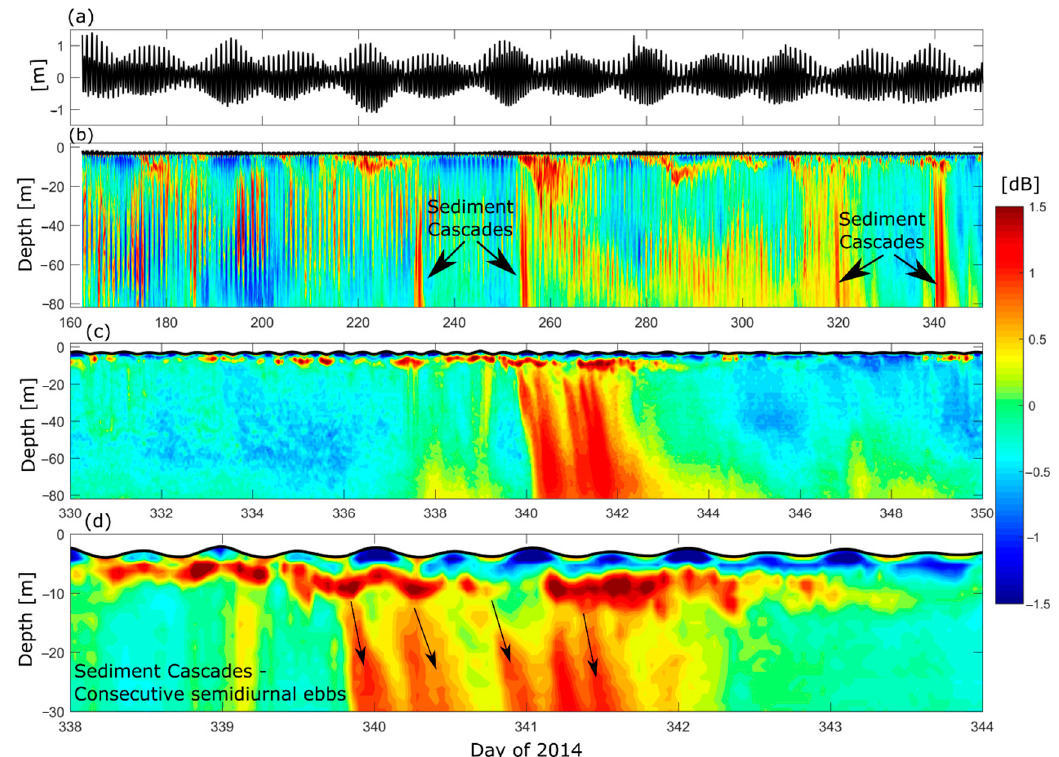
Figure 12. ( a ) Water level (m), ( b ) echo anomaly from day 160 to 350 of 2014 showing times of sediment cascades, ( c ) zoom in from day 330 to 350 of 2014 showing the sediment cascade from day 340 to 343 of 2014, ( d ) further zoom of sediment cascade from day 338 to 344 showing the sediment cascades taking place on consecutive semidiurnal ebb tides.